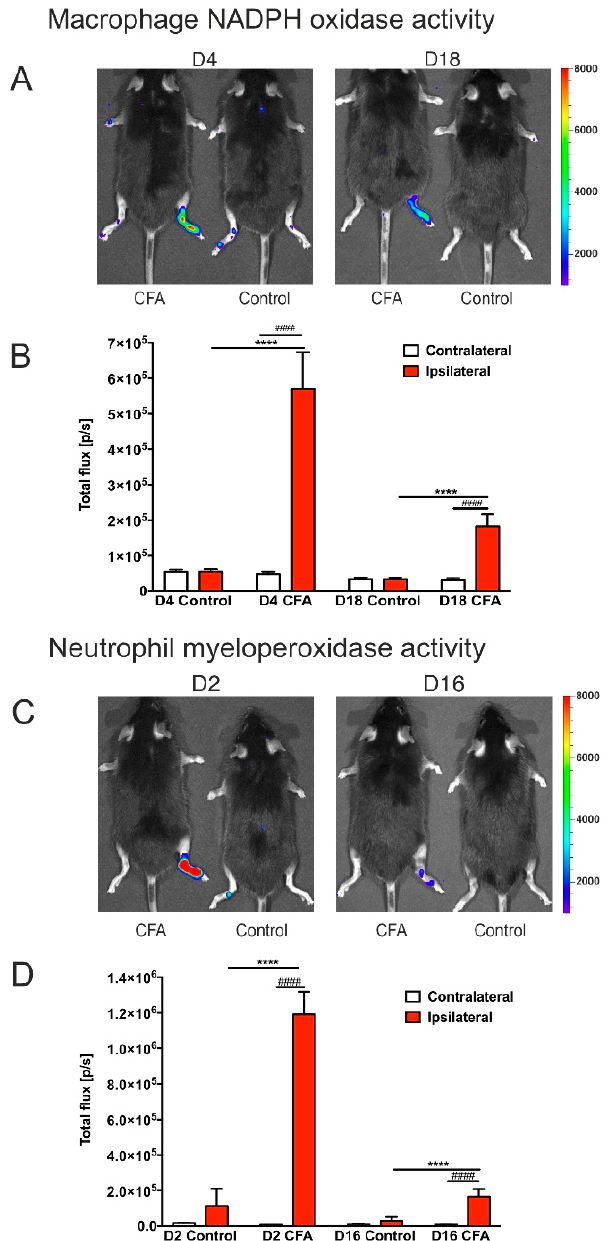
Figure 3. In vivo bioluminescence imaging demonstrating local inflammation, i.e., the presence of reactive oxygen species generated by the inflammatory phagocytes. ( A ) Images of CFA-injected and control mice. This method detects the macrophage NADPH oxidase activity after injection of lucigenin into the animals. Lucigenin reacts with the macrophage NADPH oxidases and gives a bioluminescence signal. Note the bioluminescence signals of the right hind limbs. ( B ) Quantitative data of the bioluminescent signals. ( C ) Bioluminescence signals were evoked by the injection of luminol, which reacts with the myeloperoxidase enzymes of the neutrophil granulocytes. ( D ) Quantitative data of the bioluminescence signals. The bioluminescence signal was significantly increased both in the acute and chronic phases of the inflammation. Statistical analysis: two-way ANOVA (time × CFA treatment) followed by Tukey’s multiple comparisons post hoc test. **** p < 0.0001 versus the ipsilateral hind limbs of the control mice at the same time points. #### p < 0.0001 versus the contralateral hind limbs of the CFA-injected animals at the same time points. Abbreviations: complete Freund’s adjuvant (CFA); day